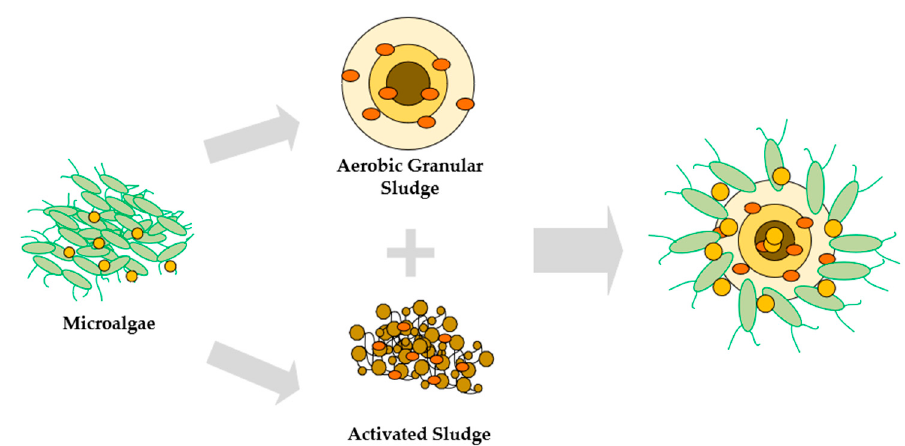
Figure 6. Stages of OPG granulation, based on [4,43].